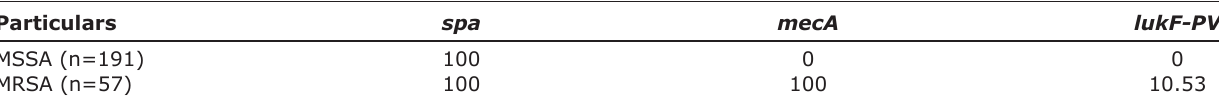
Table-4: Genotypic characterization of PVL-positive S. aureus . Particulars